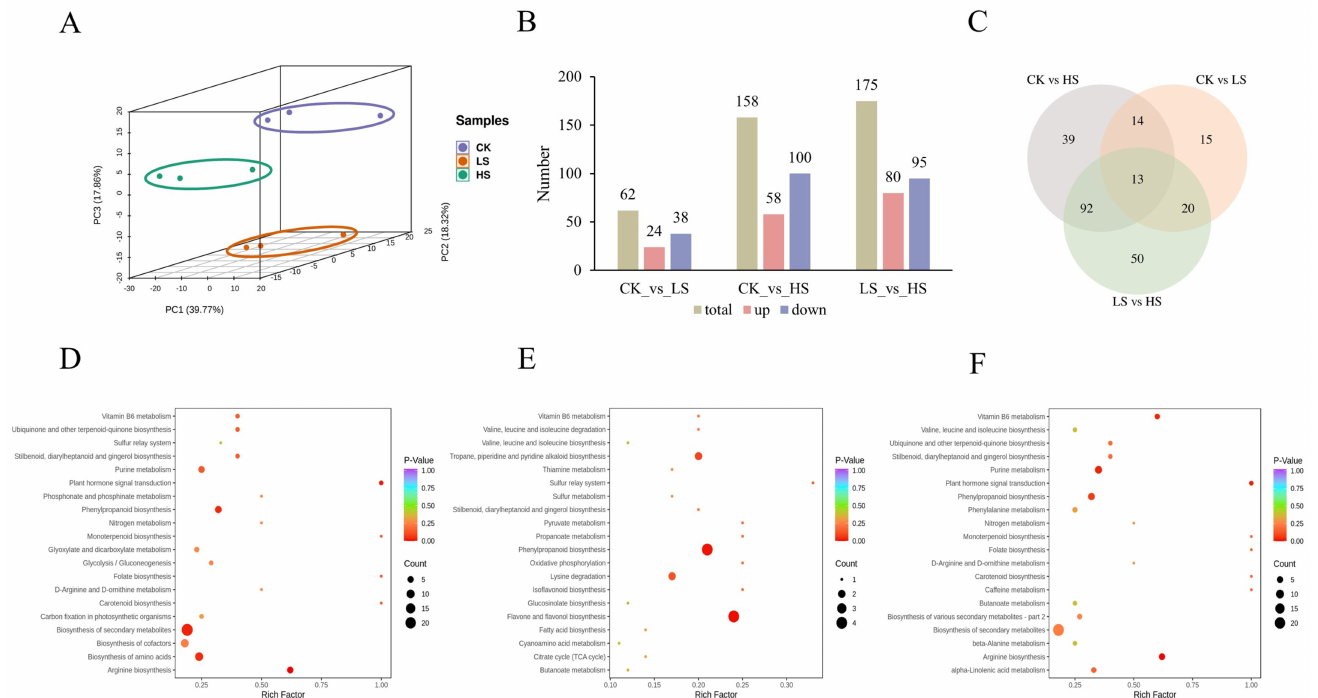
Figure 7. Identification of differentially abundant metabolites in P. koraiensis under light stress. ( A ) PCA score plot of expression profiles from different samples. ( B ) The statistical analysis of upregulated and downregulated differentially expressed metabolites in different comparison groups. ( C ) Venn diagram showing the number of metabolites in CK, LS and HS. ( D ) The top 20 KEGG enrichment pathways of differentially accumulated metabolites (DAMs) in CK vs. HS. ( E ) The top 20 KEGG enrichment pathways of DAMs in CK vs. LS. ( F ) The top 20 KEGG enrichment pathways of DAMs in LS vs. HS. CK: control. LS: light shade. HS: heavy